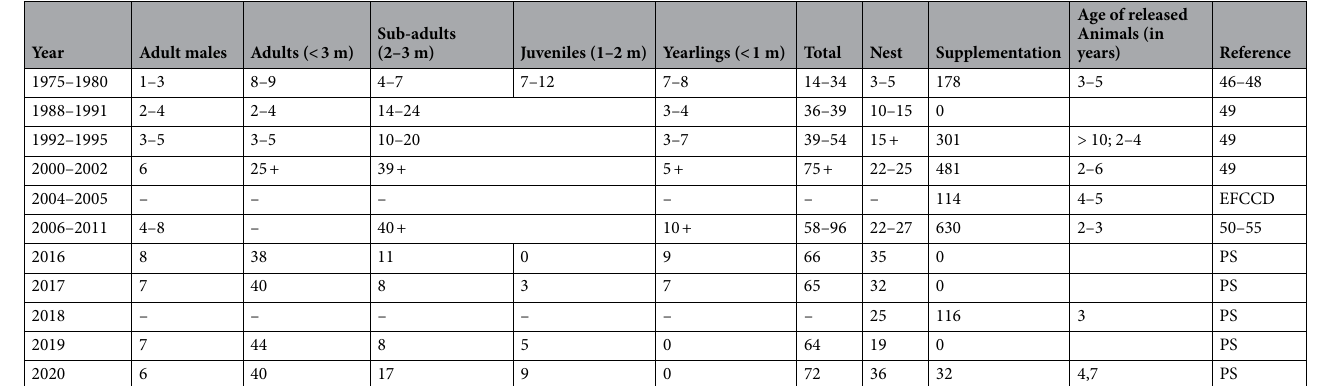
Table 1. Population counts and nest counts for the gharials resident in KWS, from 1975 to 2020. Ranges are shown, for available years (grouped by refs) for respective size/age classes, based on primary data (refs. cited). Supplementation refers to periodic releases of captive reared gharial, primarily juveniles and subadults; data provided by EFCCD, Uttar Pradesh. PS present study.